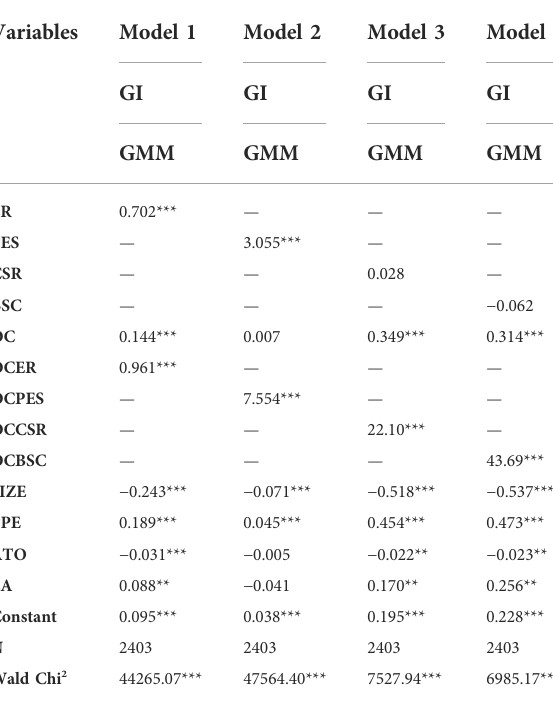
TABLE 3 Moderating role of CEO. TABLE 4 Moderating role of